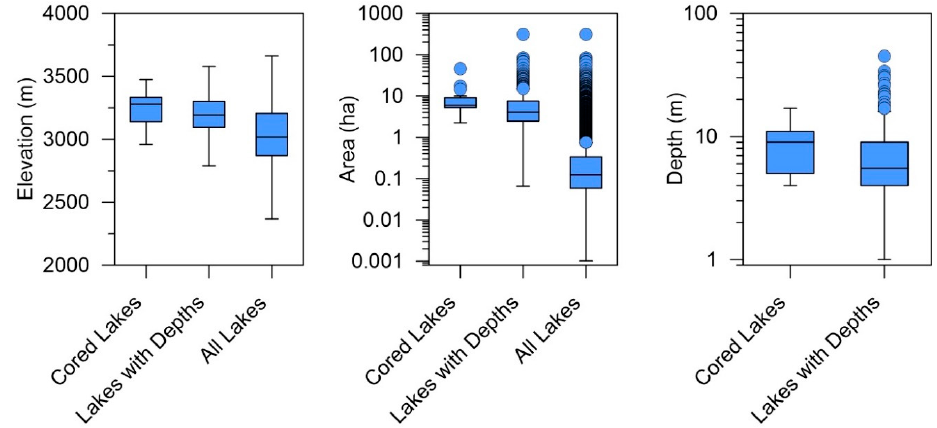
Figure 4. Distribution of elevations, areas, and depths for Uinta lakes.